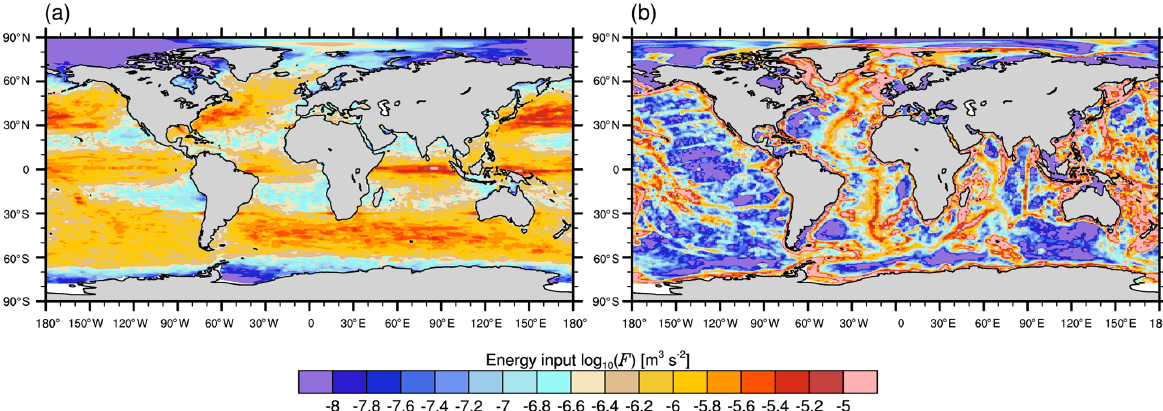
Figure A2. Energy input log 10 (F) (m 3 s − 3 ) at (a) the surface by near-inertial waves from Rimac et al. (2013) and (b) by tidal forcing at the ocean bottom from Jayne